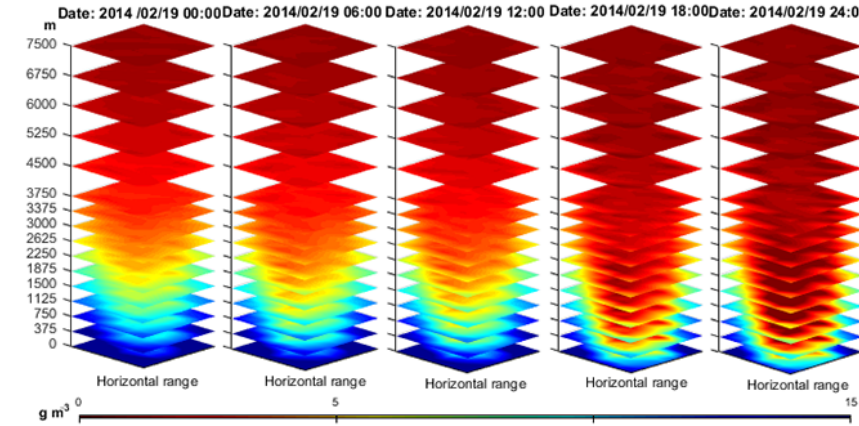
Figure 4. 3-D tomographic water vapor distribution in Hong Kong on 19 February